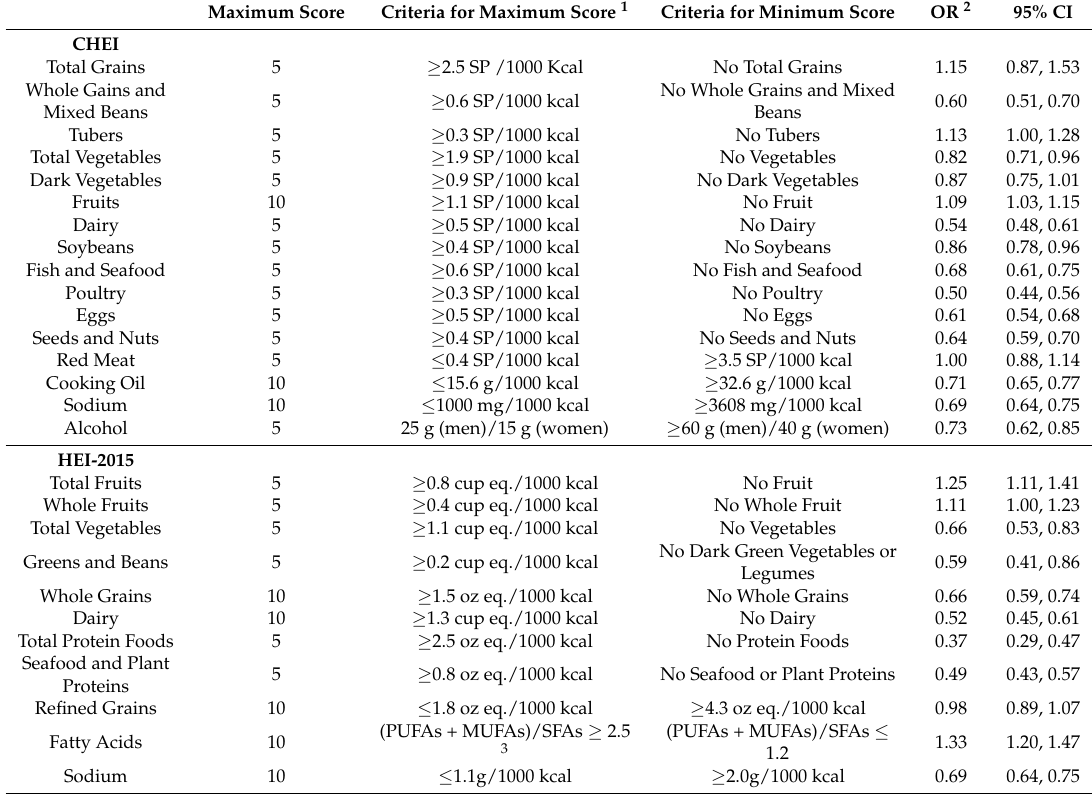
Table 3. Association of each component score of CHEI and HEI-2015 with primary liver cancer risk between case and